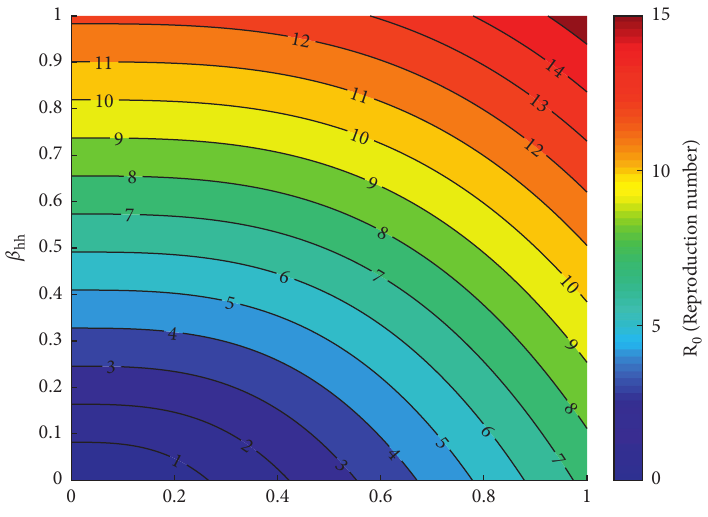
Figure 12: The contour plot of the basic reproduction number as a function of the mosquito biting rate. Number of bites per mosquito per day ( a ) and human-to-human transmission rate ( β hh ) .